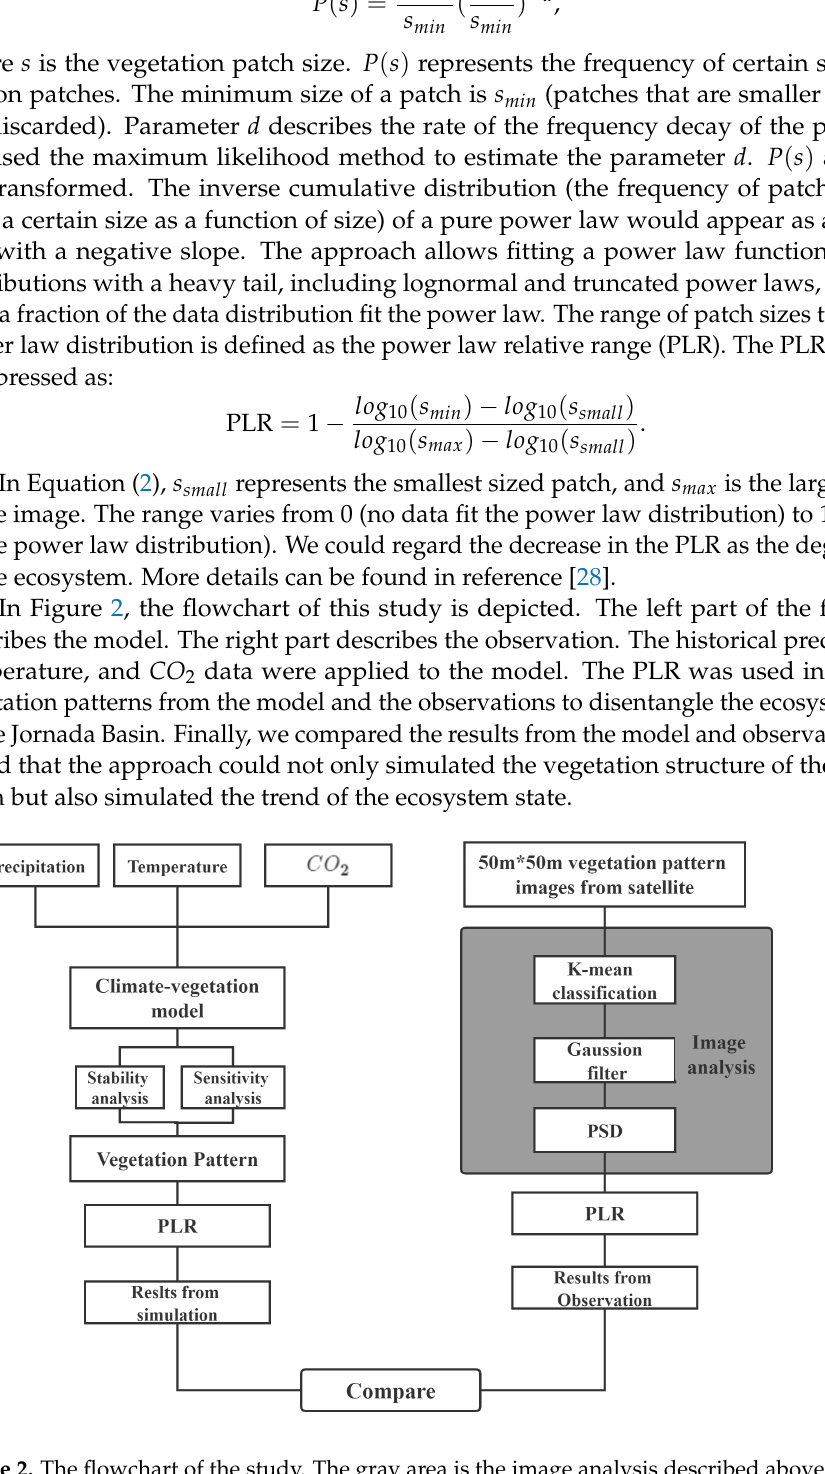
Figure 2. The flowchart of the study. The gray area is the image analysis described